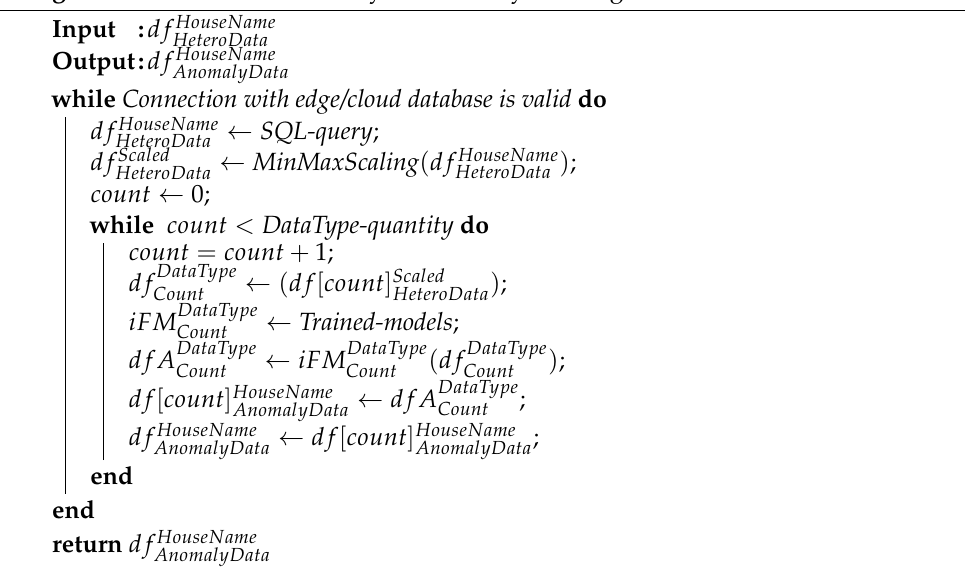
Algorithm 3: Real-time anomaly detection by utilizing individual AI models.